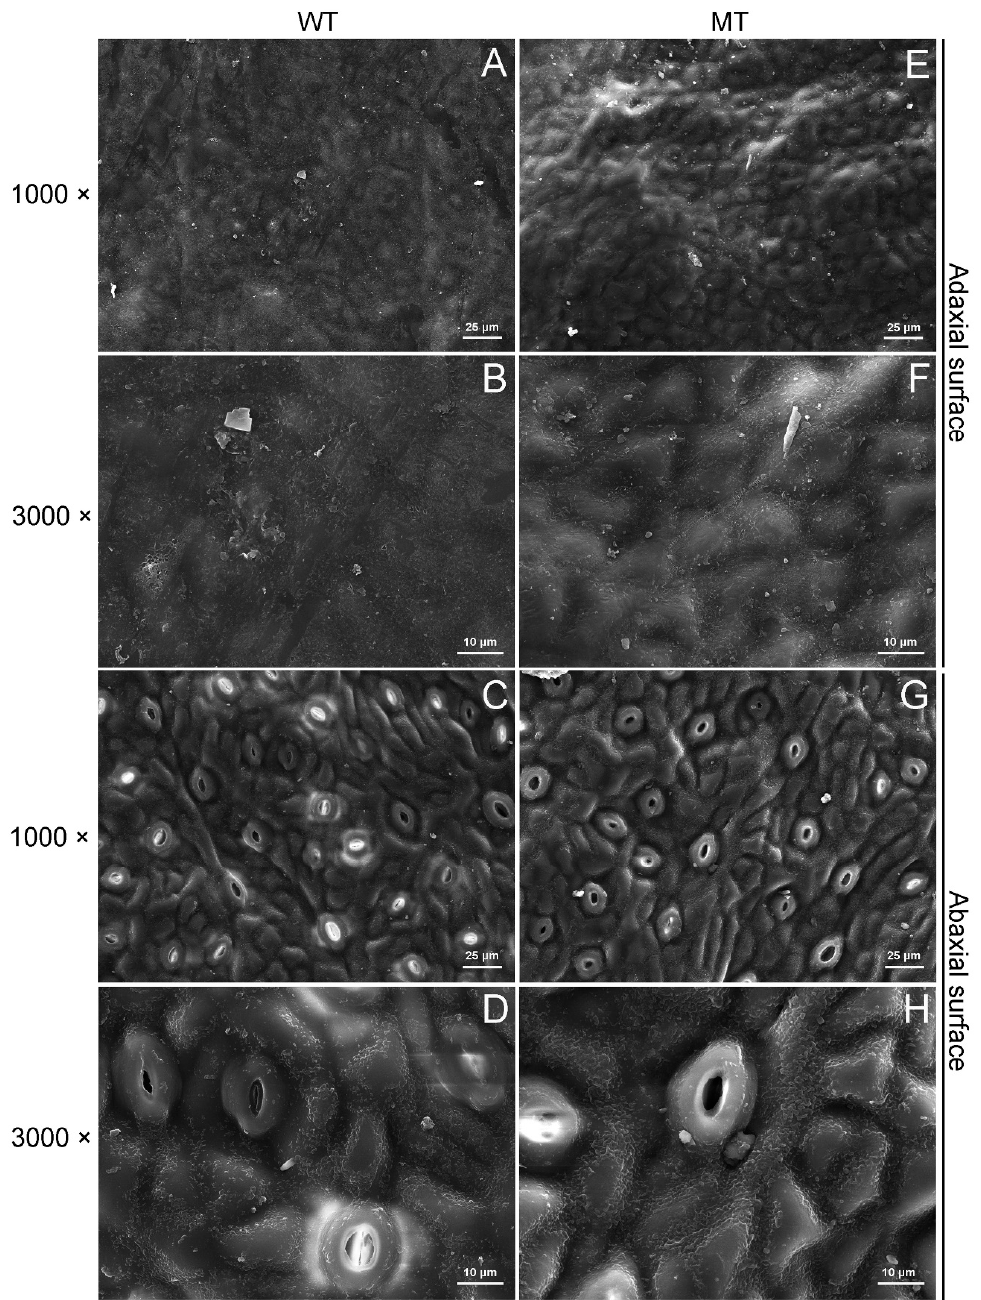
Figure 2. Scanning electron micrographs of cuticular waxes on the surfaces of WT and MT leaves. ( A , B ) The adaxial surfaces of WT leaves were imaged at 1000× and 3000× magnification. ( C , D ) The abaxial surfaces of WT leaves were imaged at 1000× and 3000× magnification. ( E , F ) The adaxial surfaces of MT leaves were imaged at 1000× and 3000× magnification. ( G , H ) The abaxial surfaces of MT leaves were imaged at 1000× and 3000× magnification.